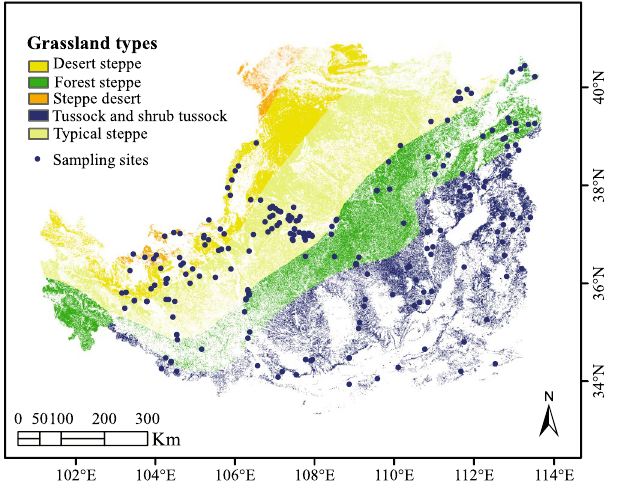
Figure 5. Sampling sites and grassland types on the Loess Plateau. The map was generated using ArcMap Version 10.0